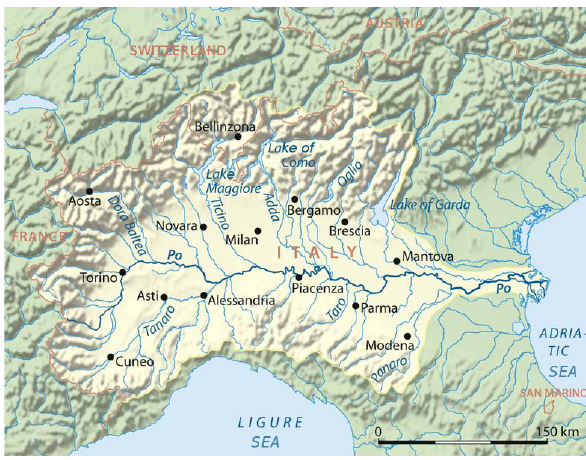
Fig. 1. Map of the Po River basin (from Wikipedia).